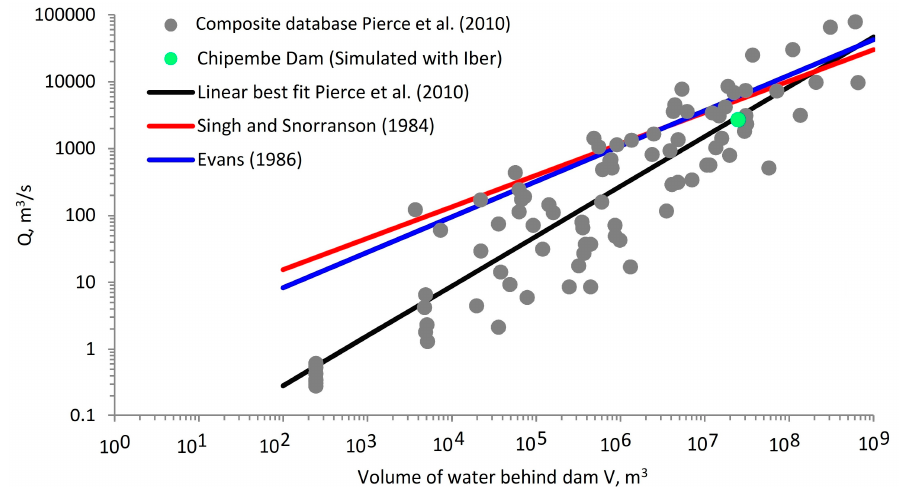
Figure 9. Comparison of the linear best-fit equations of Sing and Snorrason [57], Evans [56], Pierce et al. [27] and the peak flow predicted by the Iber model in Chipembe dam.